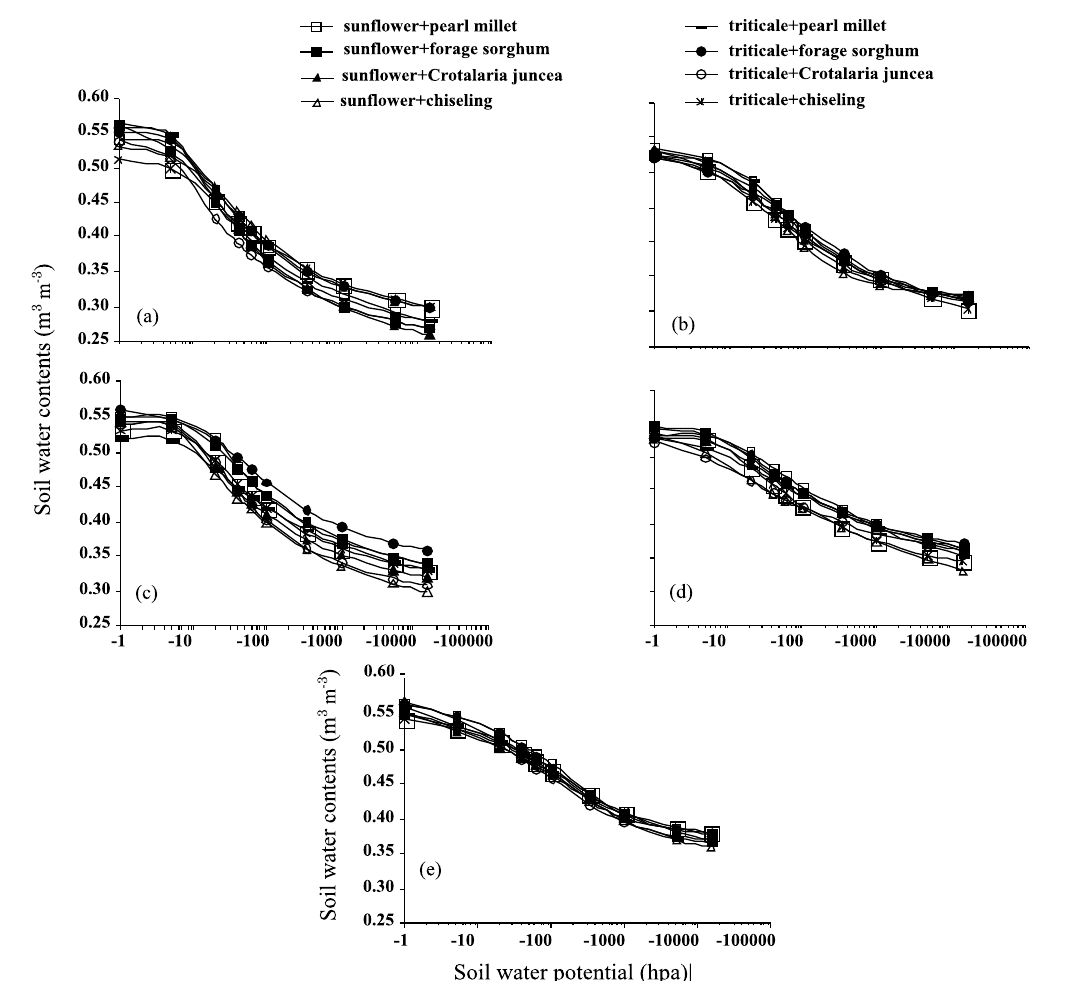
Figure 3. Soil water retention at the end of the third year of the experiment (2005/2006), as affected by crop rotation, chiseling and soil depth. (a) 0–0.05 m; (b) 0.075–0.125 m; (c) 0.15–0.20 m; (d) 0.275–0.325 m and (e) 0.475–0.525